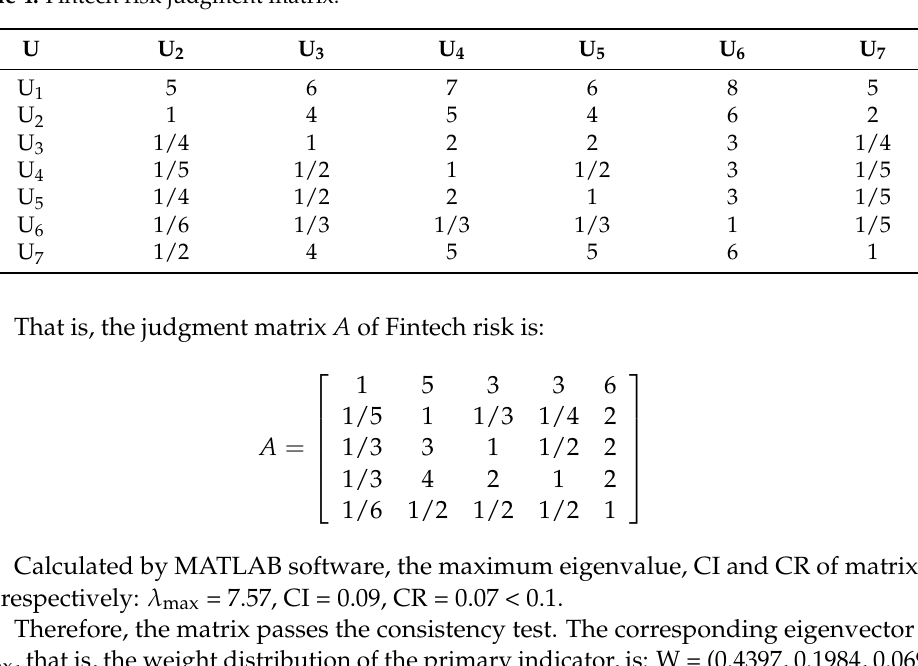
Table 4. Fintech risk judgment